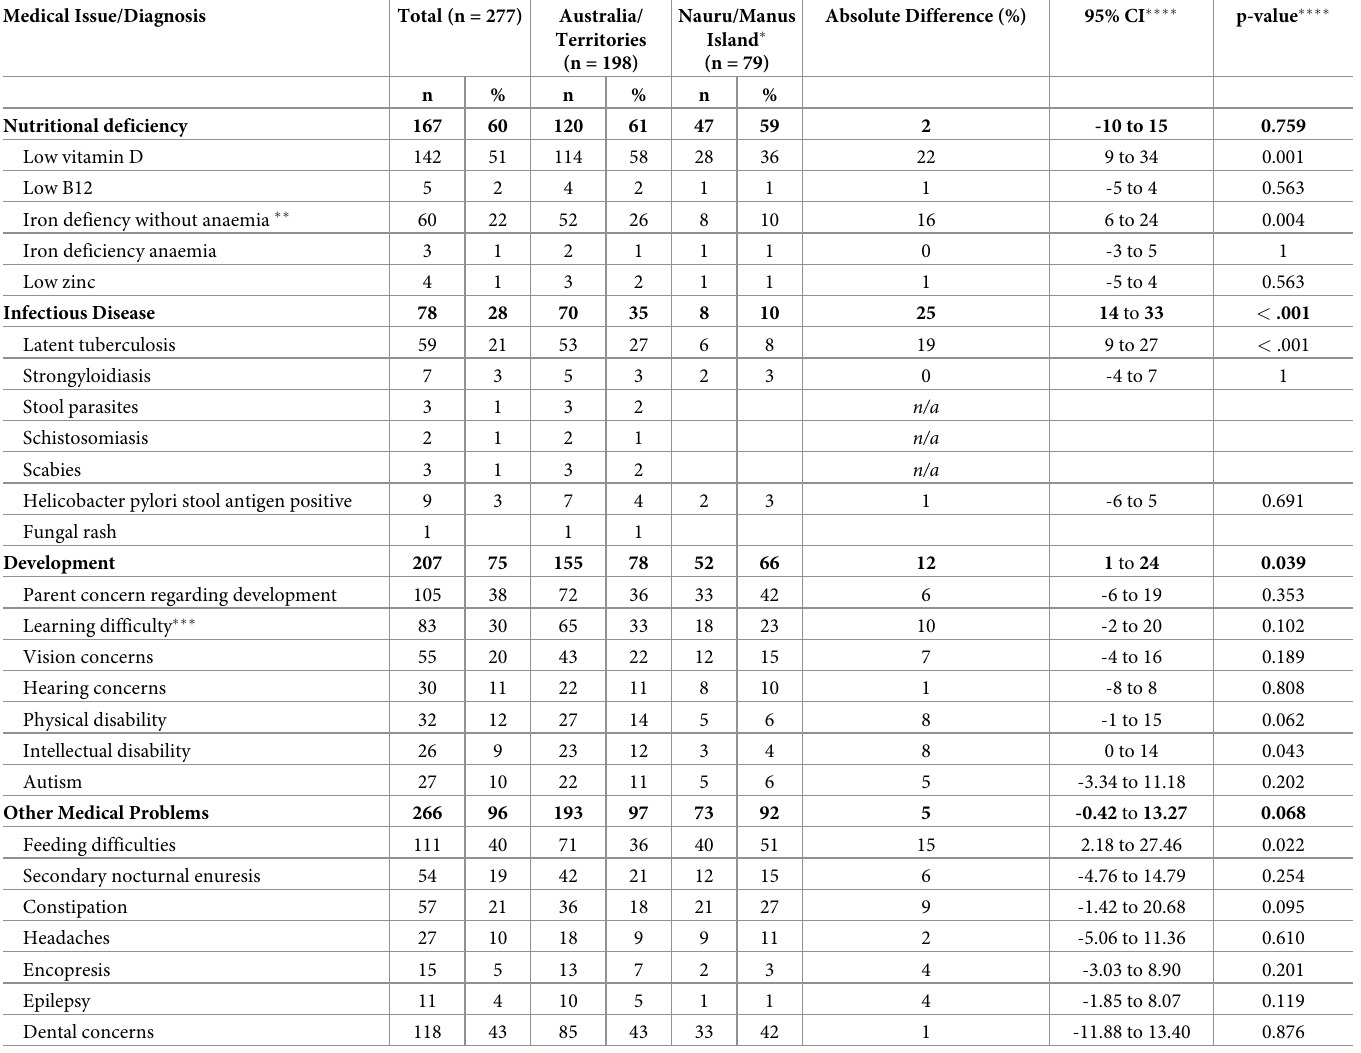
Table 2. Medical issues for children experiencing